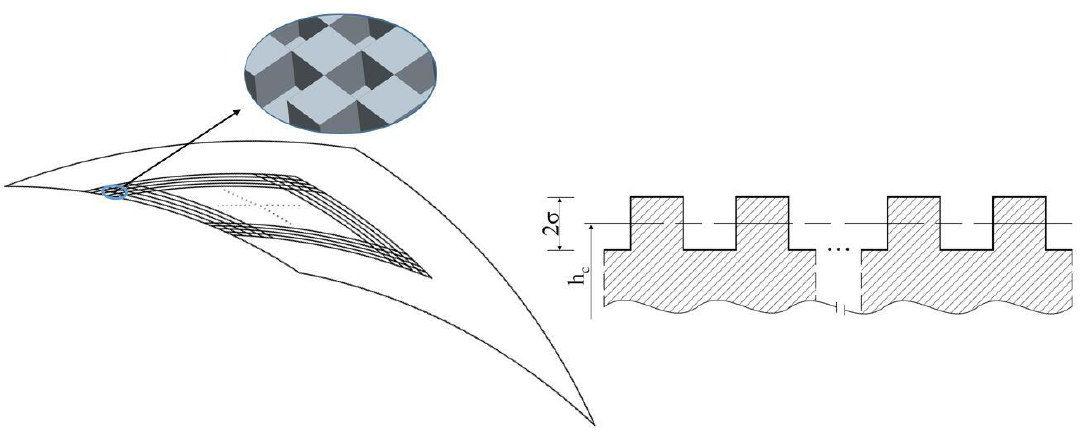
Figure 2. Rough micro-element and rough surface simulation diagram.